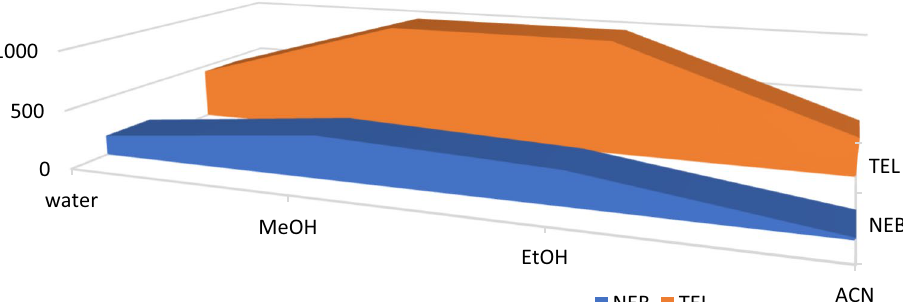
Figure 6. Effect of diluting solvents on the relative synchronous fluorescence intensity of (100.0 ng/ mL) of each NEB and